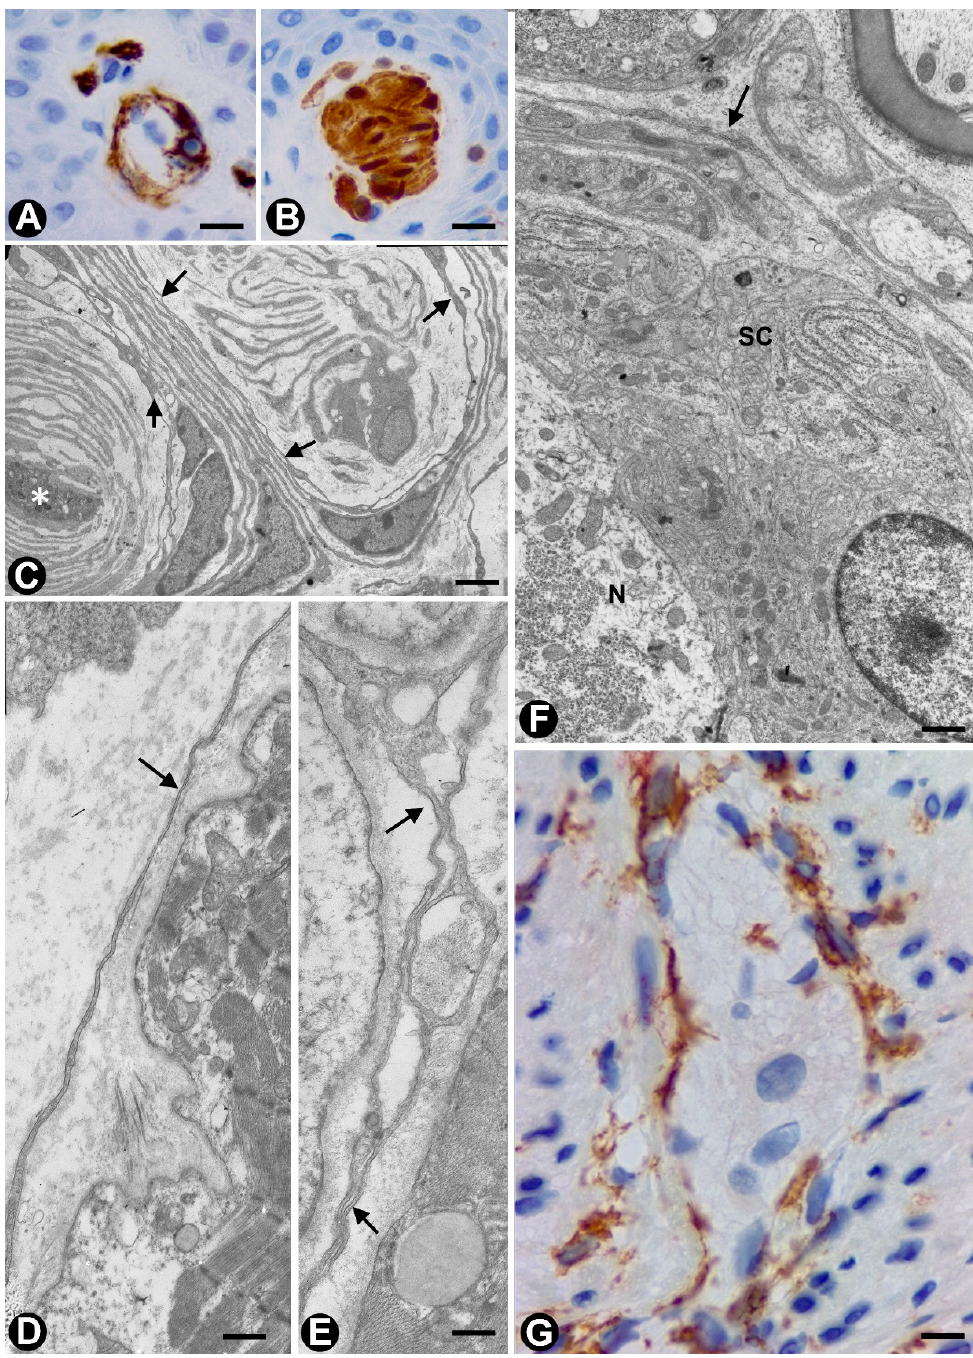
Figure 2. Examples of TCs in some sensory receptors, ganglia and the autonomic nervous system in the digestive tract ( A – C ). In Meissner corpuscles, TCs are observed in the capsule (A and C), showing CD34 expression (A, brown) and the characteristic ultrastructure (C, arrows). Schwann cells, with S100 expression (B, brown), are observed. It should be noted that in C, a nerve fibre (asterisk) surrounded by Schwann cells can be observed. ( D , E ) In neuromuscular spindles, TC telopodes (arrows) are shown around striated muscle cells. ( F ) A TC telopode (arrow) between a neuronal–glial unit (Neuron: N and satellite glial cell: SC) and nerve fibres in a spinal ganglion. ( G ) TCs expressing CD34 (brown) in an appendiceal myenteric ganglion. A, G: Sections stained with anti-CD34. B: Section stained with anti-S100. C–F. Ultrathin sections. Uranyl acetate and lead citrate. Bar: A, B, 60 µm; C, 2 µm; D, E, F, 1 µm; G, 40 µm